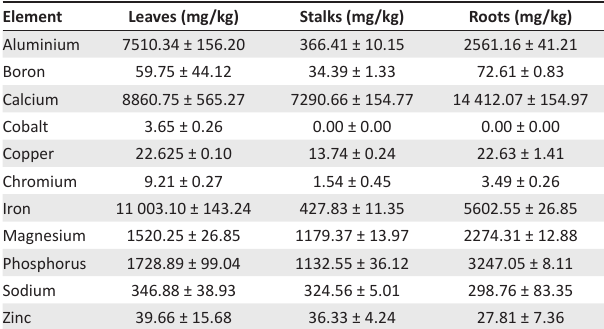
TABLE 2: Micro- and macronutrient compositions of Lantana trifolia